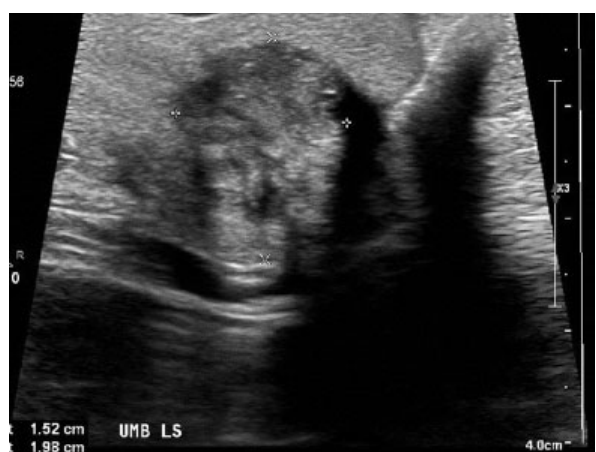
Fig. 1 Ultrasonography of the umbilicus demonstrated a 2 (cid:1) 1.5cm heterogeneous echogenic material within the